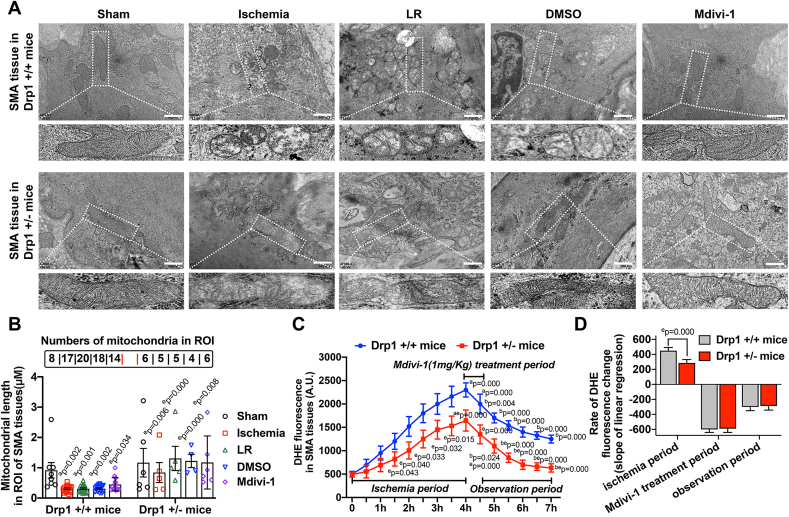
Effects of Mdivi-1 on ischemia-induced oxidative stress in Drp1 knockdown mice. (A) TEM images showing mitochondria in SMA tissues from Drp1 +/+ mice or Drp1 +/- mice. The enlarged images showing the inner cristae structures of mitochondria (bar = 500 nm). (B) Quantitative data in the length of each mitochondrial individuals in ROI (regions of interest) from SMA tissues. Numbers of mitochondria were labeled in the top of each group. (C) DHE fluorescence (arbitrary units, A.U.) of SMA tissues was measured in different periods (30min interval) in Drp1 +/+ or Drp1 +/- mice (8 mice/group). (D) Rate of DHE fluorescence change in Drp1 +/+ or Drp1 +/- mice. The rates were represented by the slope of linear regression in each period (8 mice/group). a: P < 0.05 compared with Sham group of the same genotype mice, b: P < 0.05 compared with Ischemia group of the same genotype mice, c: P < 0.05 compared with LR group of the same genotype mice, d: P < 0.05 compared with DMSO group of the same genotype mice, e: P < 0.05 compared with Drp1 +/+ mice at the same time point.